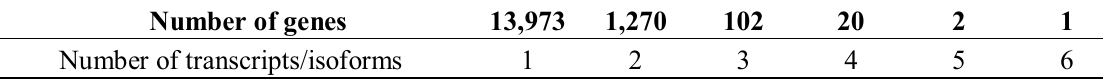
Table 1. Transcripts showing altered levels relative to the previous time point. The total number of genes that had significant transcriptional changes for at least one of their isoforms was 15,368, while the number of genes with more than one differentially expressed transcript was 1,395. The total number of isoforms for multi-transcript genes showing differential expression was 2,942. The level of significance for differential expression was set by using the p -value cutoff of 0.05.